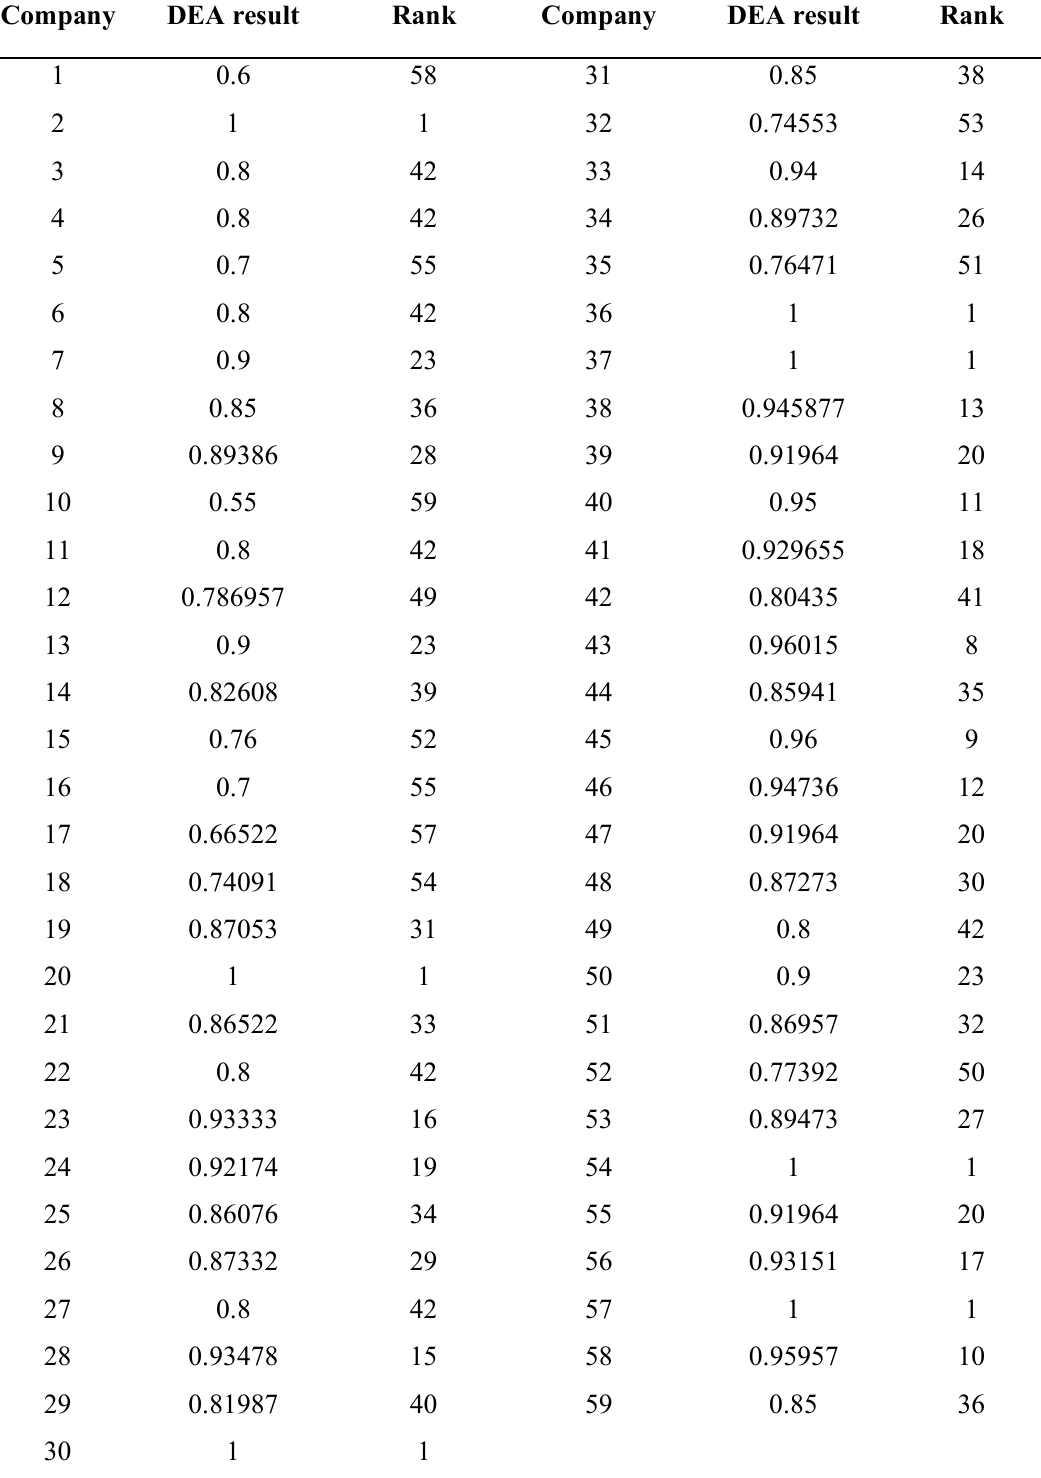
Table 2. Results of full ranking output-oriented DEA model